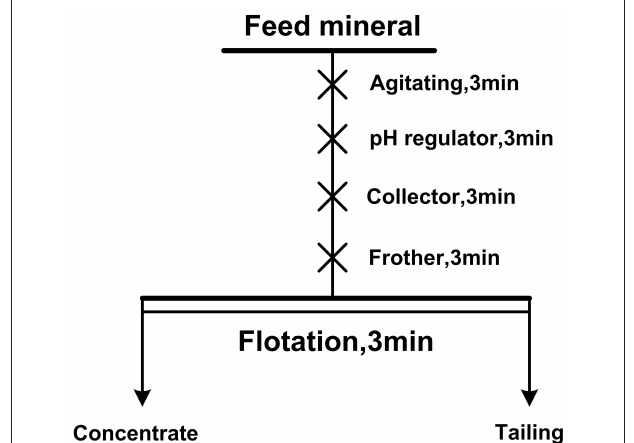
FIGURE 1 | Flowsheet of the flotation tests.